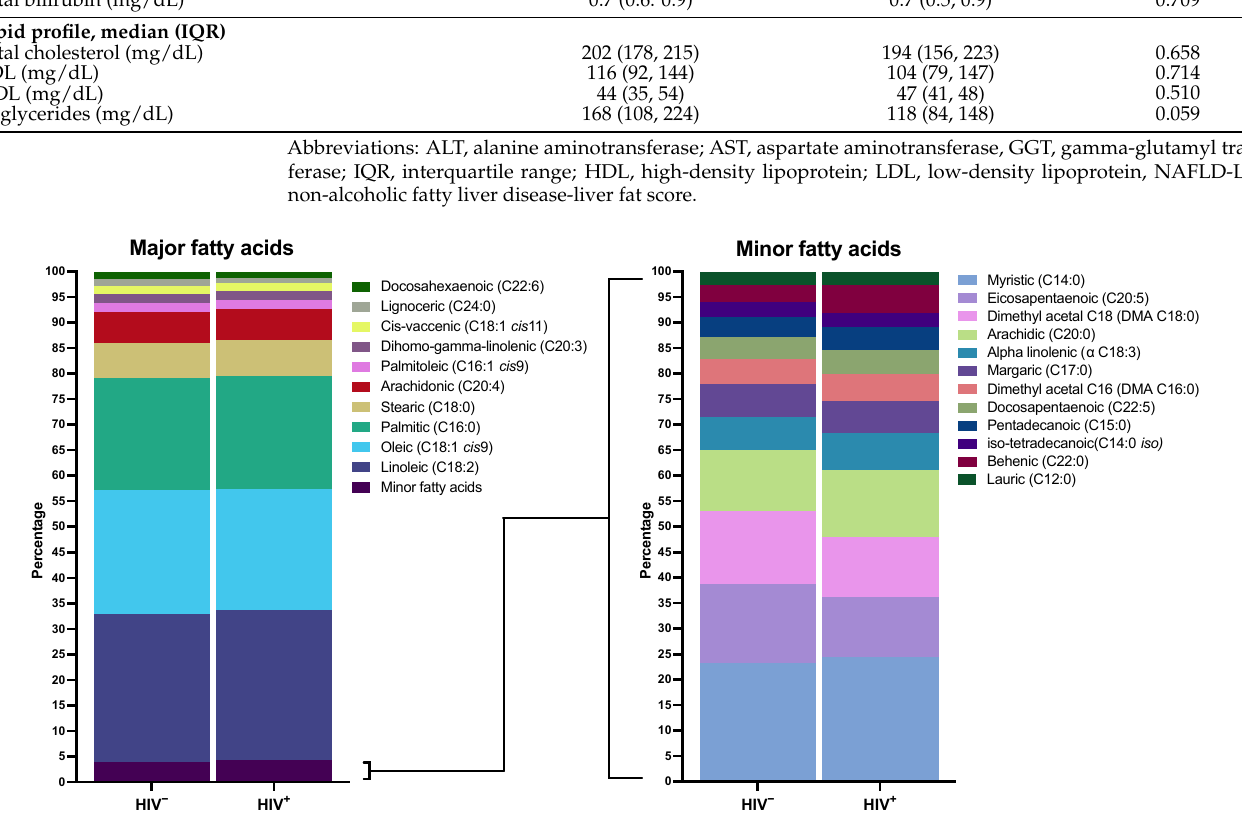
Figure 3. Main differences in plasma fatty acids and estimated activity of ELOVL1 and ELOVL6 elongases, according to HIV status. The dot plots show the most significant differences between the two groups regarding fatty acids plasma concentrations and calculated ratios. C24:0/C22:0 and C16:0/C14:0 ratios estimate the activity of ELOVL1 and ELOVL6 elongases, respectively. The p ‐ value is obtained from the adjusted linear regression model.